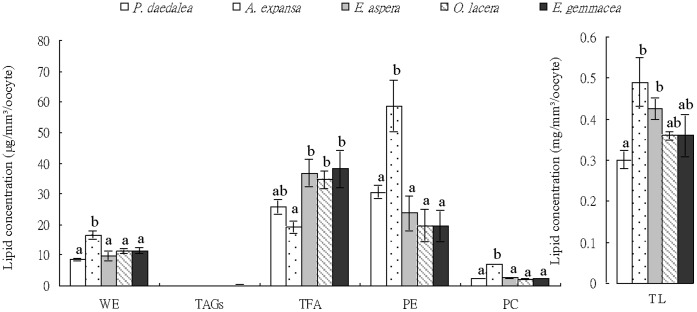
Concentrations of total lipids (TL), wax esters (WE), fatty acids (FA), phosphatidyethanolamine (PE), and phosphatidylcholine (PC) extracted from oocytes of P. daedalea, E. gemmacea, E. aspera, O. lacera, and A. expansa.Error bars indicate standard error of the mean. Statistically significant differences (Tukey’s HSD, p<0.05) within each lipid species are denoted by letter groups.